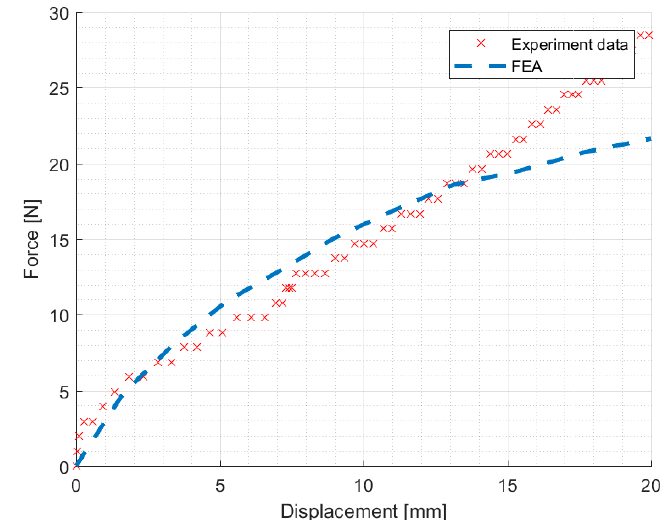
Figure 6. Experimental data expressed as points and finite element analysis (FEA) results expressed as